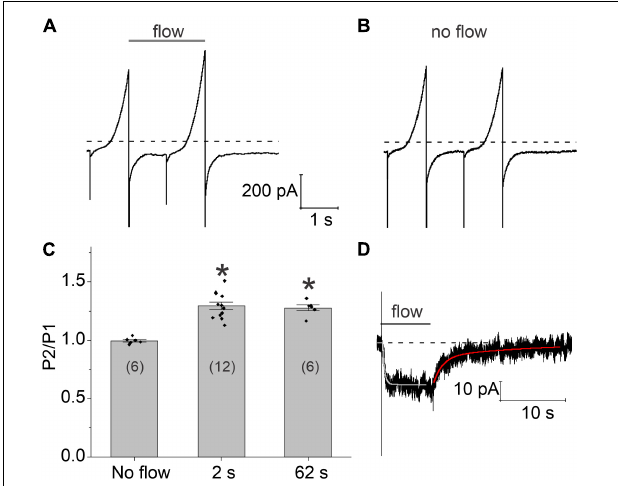
FIGURE 3 | Time course of development and recovery of the flow-induced, chloride current. (A) Representative experiment showing the effect of fluid flow on the whole cell current using a paired ramp protocol. In this protocol, two 1 s ramps from –100 to + 100 mV were applied in succession from a holding potential of –60 mV. The time interval between the two ramps was 1 s. Application of fluid flow (gray bar) resulted in a significant increase in the amplitude of the current during the second (test) ramp pulse. (B) Whole cell currents recorded from the same cell in the absence of fluid flow. (C) Bar graph summarizing the effect of fluid flow on the amplitude of the membrane current peak at 100 mV recorded during the second ramp (P2) normalized with respect to the current peak at 100 mV recorded during the first ramp (P1). The number of cells tested is indicated within parentheses. Significant differences (*) are relative to the no flow condition. The bath solution consisted of NaCl external solution. The pipette consisted of CsCl internal solution containing 200–300 nM [Ca 2 + ] i . (D) Representative experiment showing the effect of an 8 s fluid pulse on the holding current at –60 mV. Solid lines drawn through the data are single and double exponential fits to the rising (light gray) and declining (red) phase of the current, respectively. Bath solution consisted of NMDG-Cl external solution. Pipette solution consisted of NMDG-Cl internal solution containing ∼ 300 nM [Ca 2 + ] i . Dashed line represents zero current level.